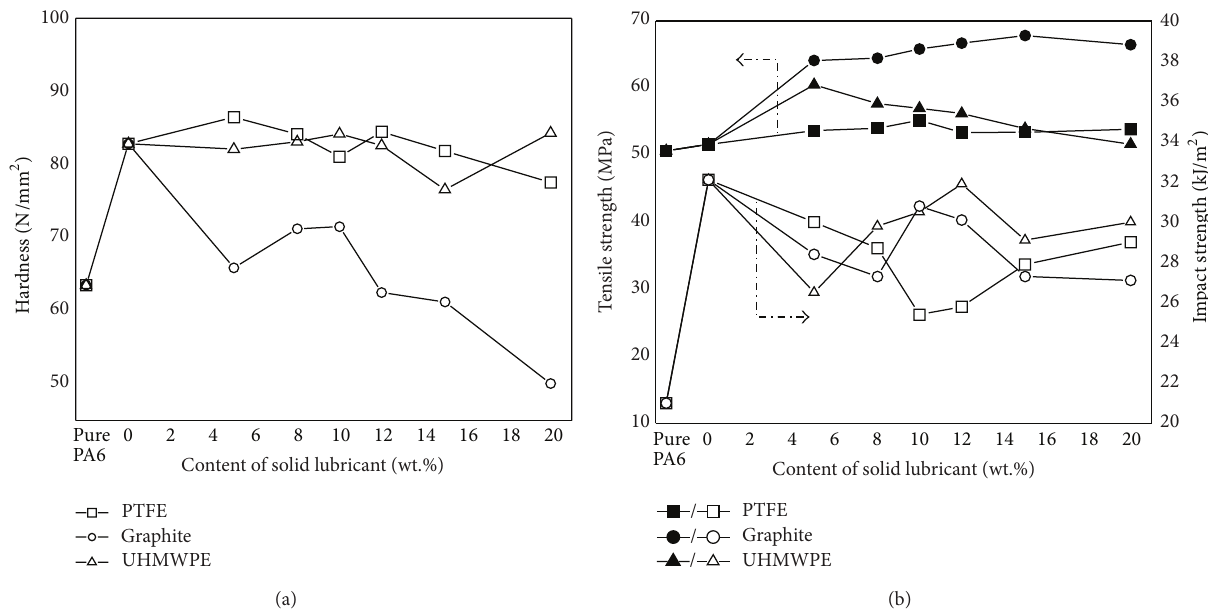
Figure 1: Mechanical property of PA6/GF composites filled with different single solid lubricant (content at zero is PA6/GF-15 sample). (a) Hardness. (b) Tensile strength and impact